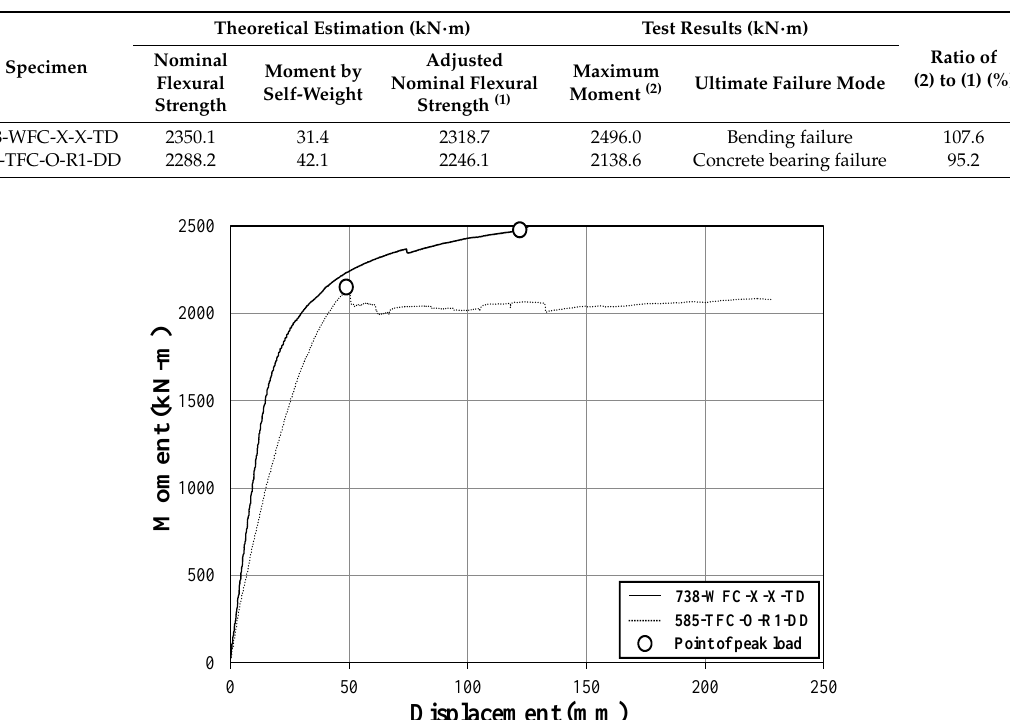
Table 12. Test results of the fully composite specimens.